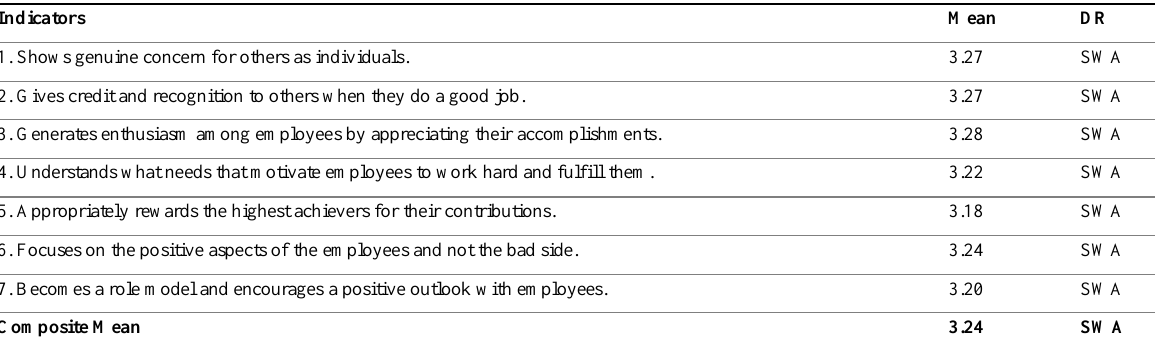
Table 5: The Leadership Skills of Office Heads of Divine Word Colleges in the Ilocos Region in terms of Motivating People Indicators Mean DR